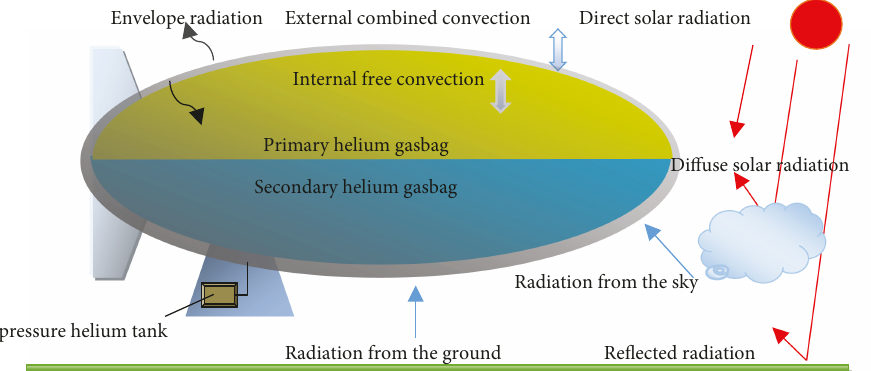
Figure 1: Schematic diagram of the thermal environment of an